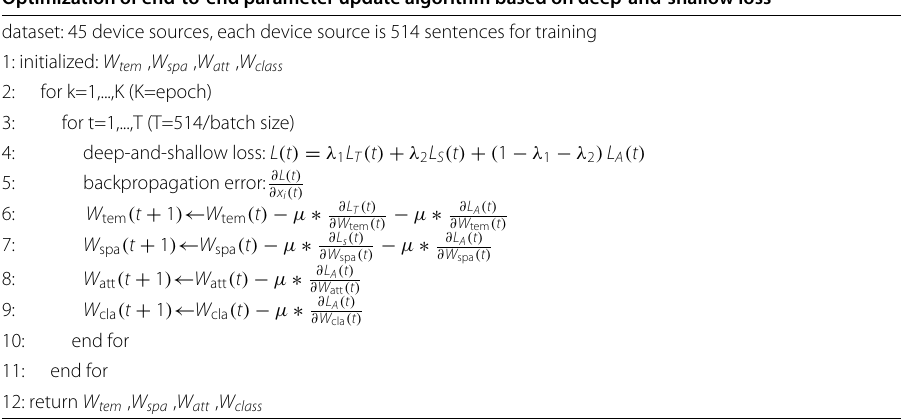
Table 1 End-to-End joint training Optimization of end-to-end parameter update algorithm based on deep-and-shallow loss dataset: 45 device sources, each device source is 514 sentences for